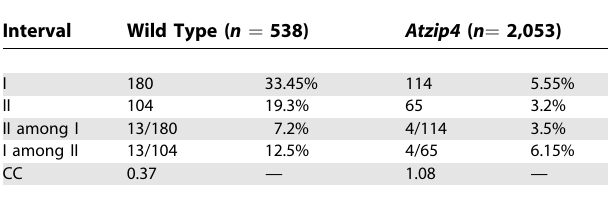
Table 3. CO Interference between Two Chromosome I Intervals Interval Wild Type ( n ¼ 538) Atzip4 ( n ¼